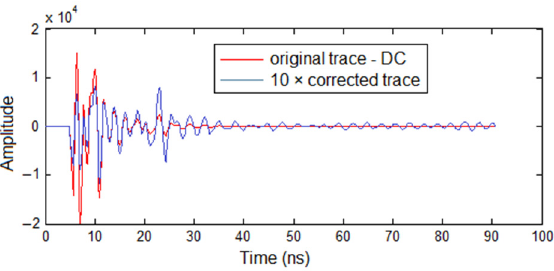
Figure 5. Example of an original trace (red) and the same trace corrected by the propagation function— geometric effects (blue). Corrected amplitudes have been multiplied by 10 for better visualization.